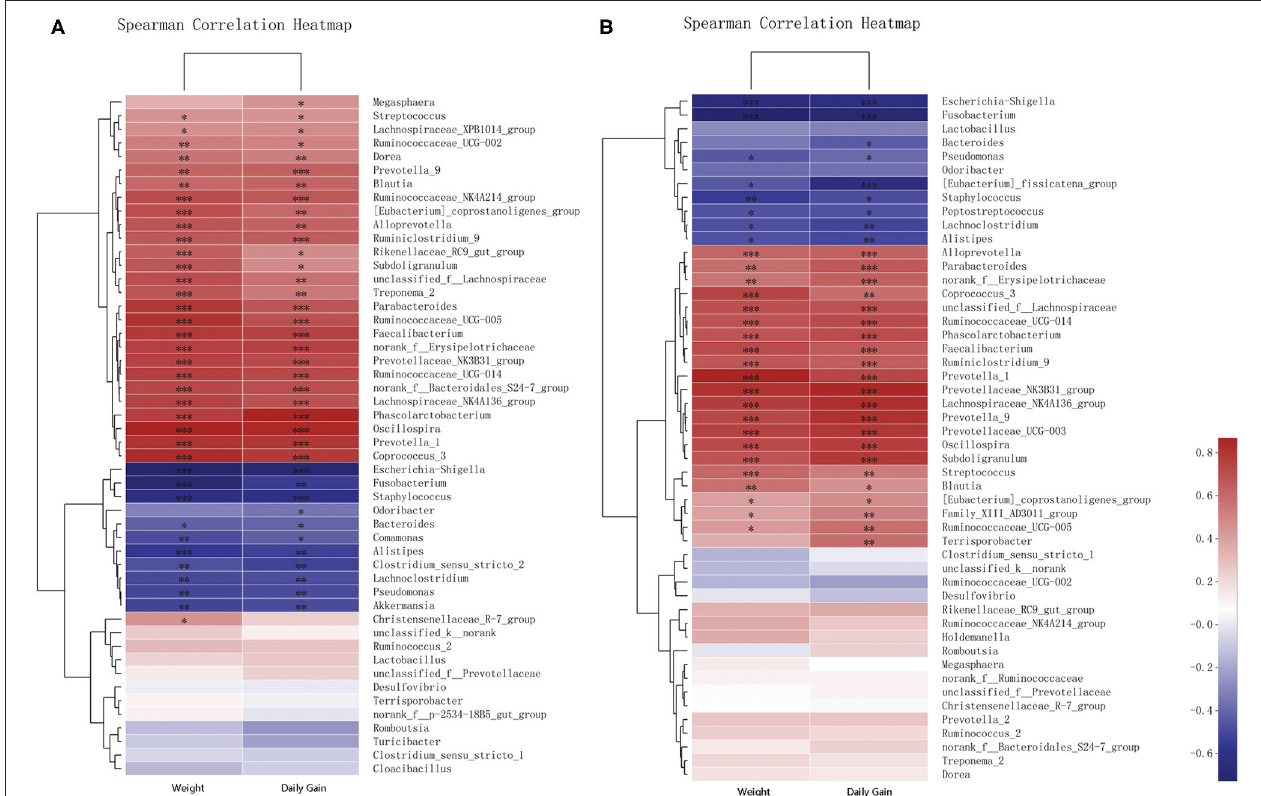
FIGURE 6 | Correlation analysis of genera and environmental variables. (A) Correlation between Jinfen White piglets and environmental variables and (B) Correlation between Mashen piglets and environmental variables. The relationships between microbial genera found in samples and environmental variables are displayed in heatmaps with correlation coefficients. Columns and rows represent environmental factors and genera, respectively. R - and P -values were calculated. R -values are represented by colors, as indicated in the figure legend on the right side of the figure. JBW, Body weight of Jinfen White piglets and MSW, Body weight of Mashen piglets. * P < 0.05, ** P < 0.01, and *** P < 0.001 indicate significant correlation between microbial genera and weight or daily